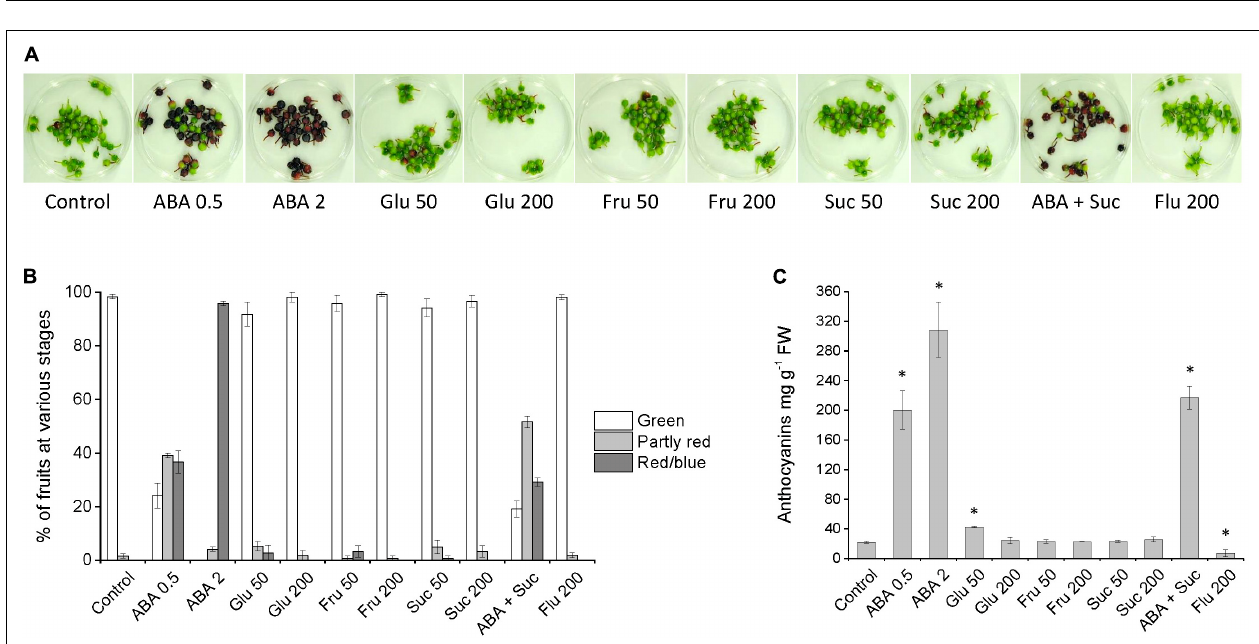
FIGURE 2 | Effect of pre-harvest treatments with glucose and sucrose on bilberry fruit anthocyanin content (A) and fruit color (B) . Unripe green berries attached to plants were sprayed with 200 mM glucose, 200 mM sucrose or water (control). Total anthocyanin content in fruits was measured after 7 and 19 days from the beginning of the experiment and is expressed as milligrams of cyanidin-3-glucoside equivalents g - 1 FW. Fruit color was evaluated after 19 days from the beginning of the experiment. Values represent means ± SEs of four replicates.